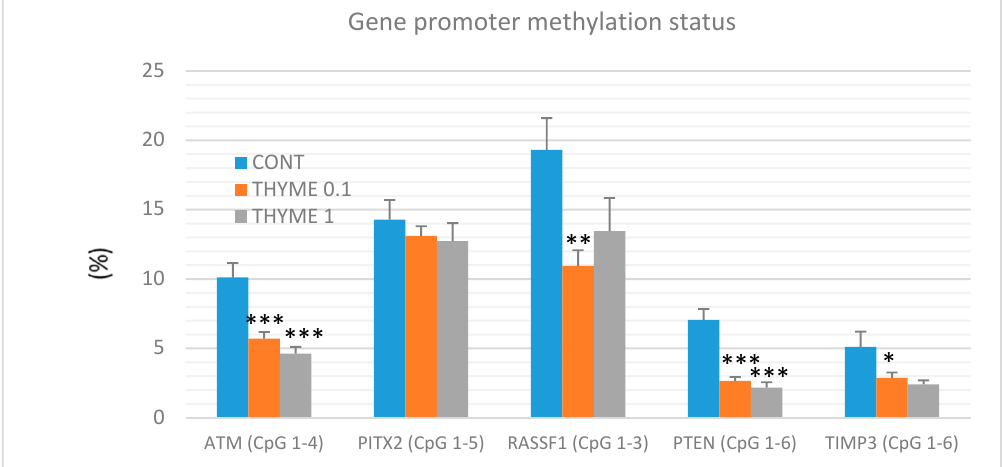
Figure 7. Total DNA promoter methylation status of ATM, PITX2, RASSF1A, PTEN, and TIMP3 genes in rat mammary carcinomas. Total promoter methylation status was taken from all evaluated CpG areas of ATM, PITX2, RASSF1A, PTEN, and TIMP3 in mammary carcinomas in the control and treated groups. Significant difference, * p < 0.05, ** p < 0.01, *** p < 0.001 versus control.